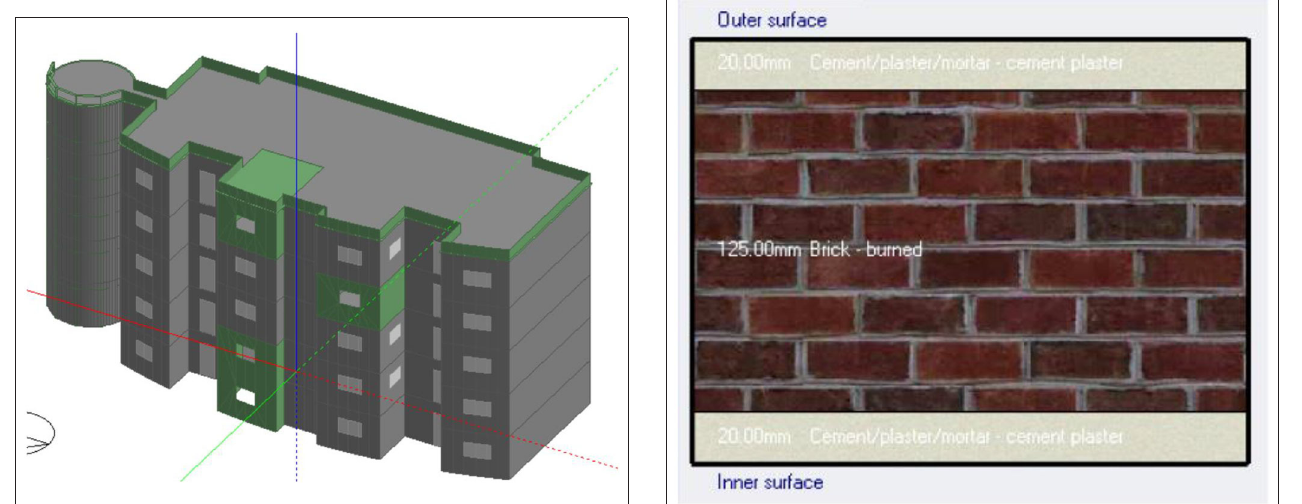
FIGURE 12 | The modified building shape after being received by DesignBuilder. FIGURE 14 | The external wall building envelope layers.